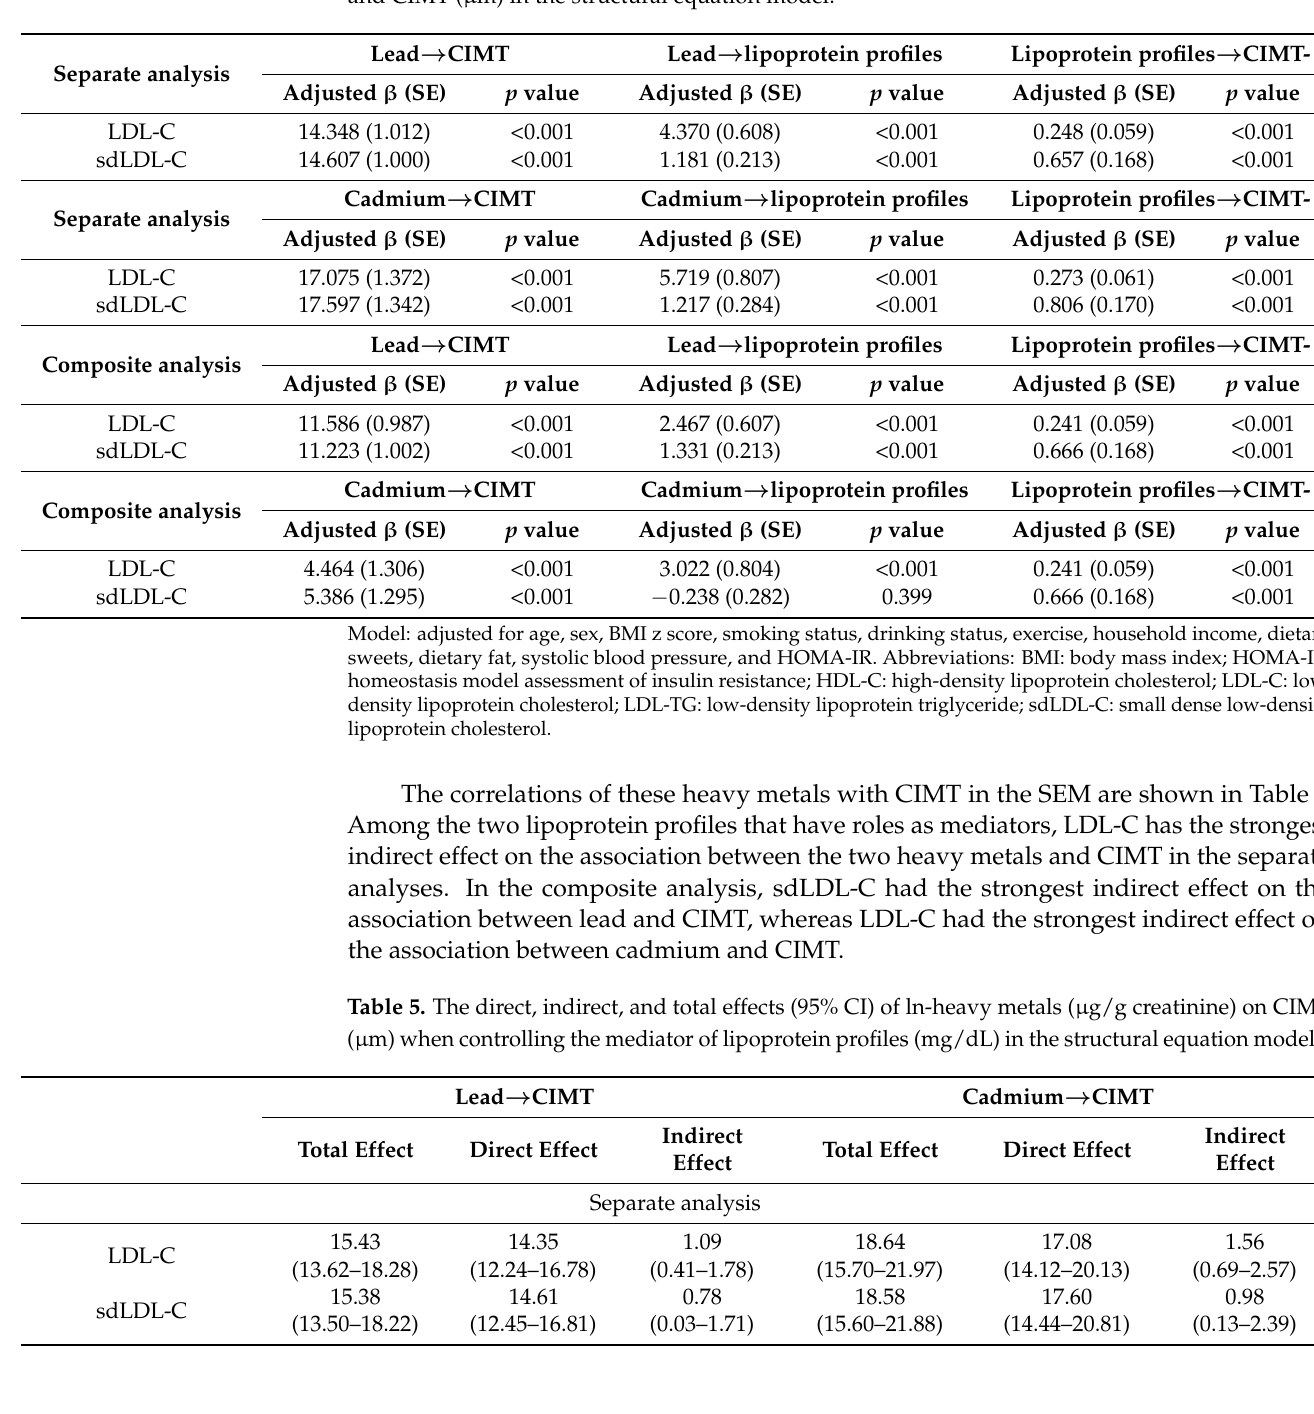
Table 4. The relationship between Ln heavy metals ( µ g/g creatinine), lipoprotein profiles (mg/dL), and CIMT ( µ m) in the structural equation model.